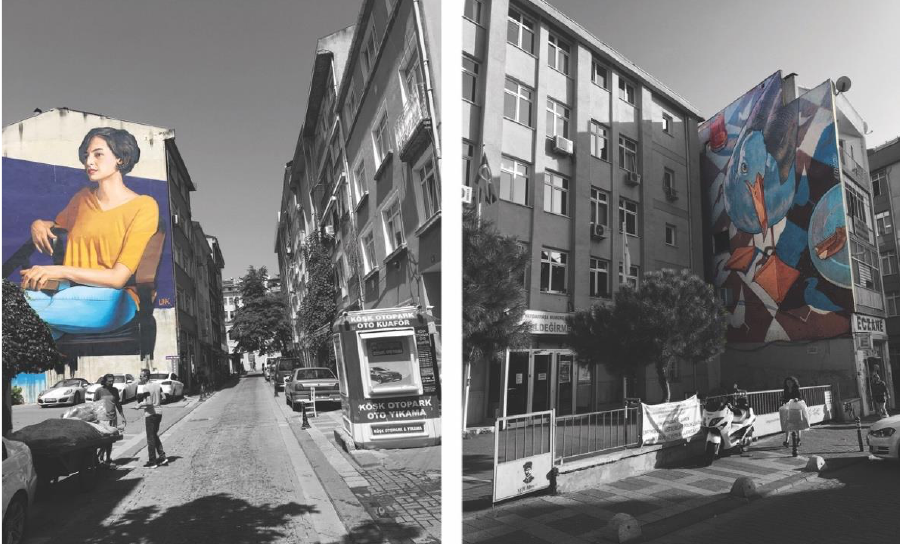
Figure 9 The singular image represented in an exaggerated size creates a dramatic visual effect on the street (left), the detailed figure on the mural increases the grain of the perceived texture of the